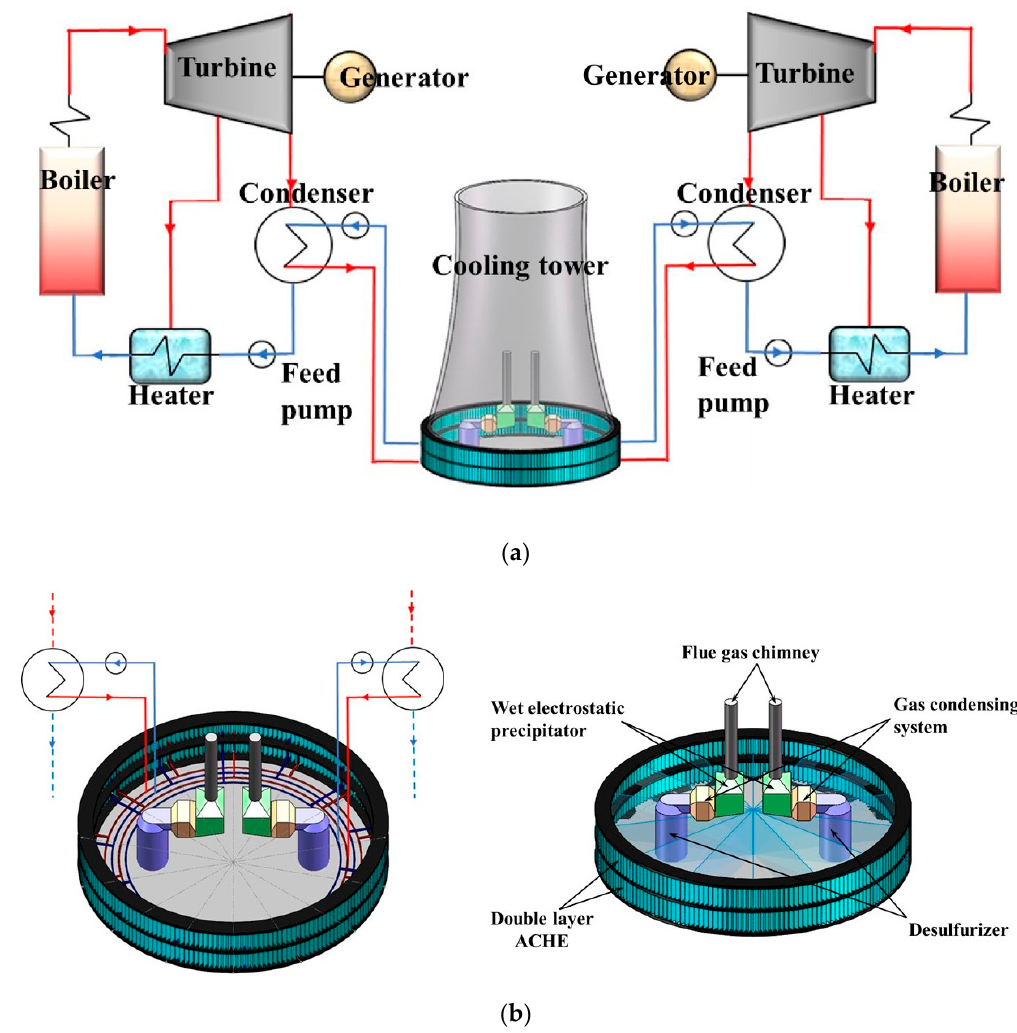
Figure 1. Geometric model. ( a ) Natural draft dry cooling system (NDDCS) with only one tower in a typical 2 × 660 MW power plant; ( b ) double-layer air-cooled heat exchanger (ACHE), desulfurizer, gas-condensing system (GCS), wet electro- static precipitator (WESP), and flue gas chimney inside tower.